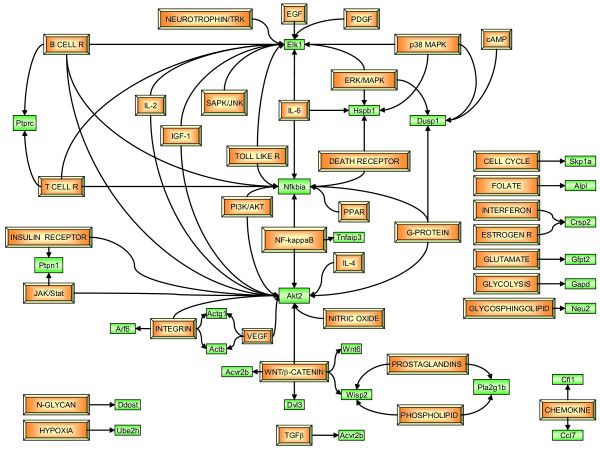
Participation of PAR1-dependent genes in canonical pathways. The experimental datasets of PAR1-dependent genes was used to query the Ingenuity Pathways Analysis [IPA] and overlaid to canonical pathways.